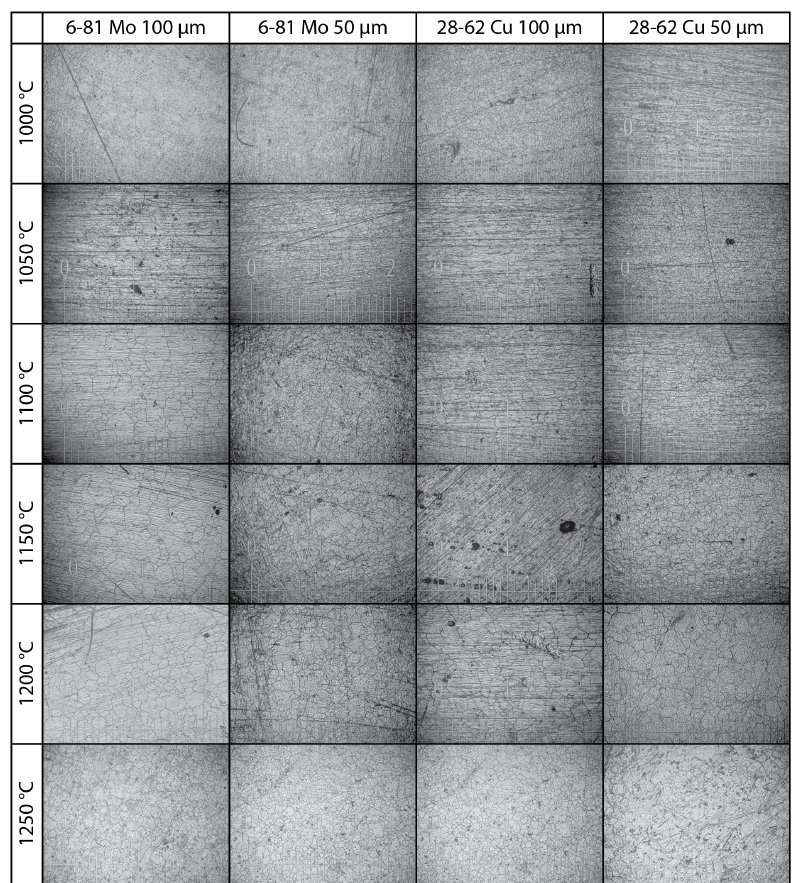
Figure A1. Photographs of each coupon showing grain size. Major ticks in the graticules show 1mm spacing.